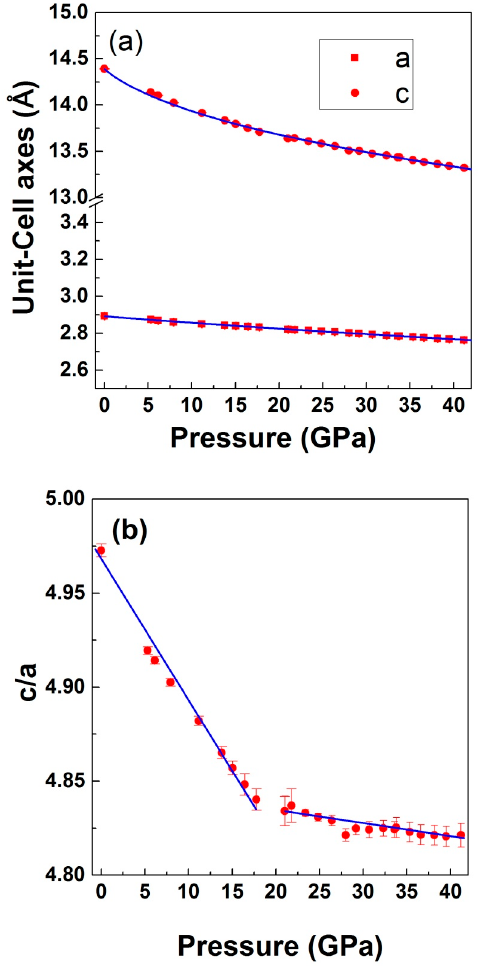
Figure 7. Pressure dependence of ( a ) lattice parameters and ( b ) axial ratio ( c / a ) of LiCrO 2 . Symbols present the experimental data points and the solid lines in ( a ) are a Birch–Murnaghan equation of state (BM–EOS) fit to the data. Error bars have also been plotted in the data. A clear slope change in c / a ratio can be seen.